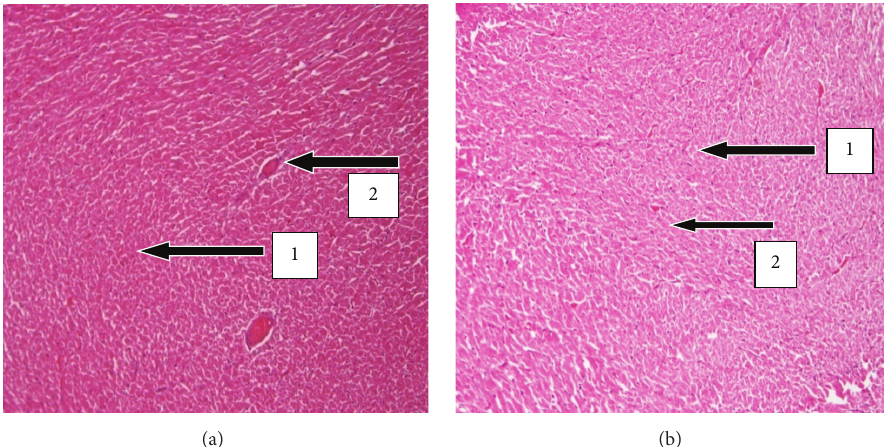
Figure 4: H&E stained sections of hearts at 20x magnification. (a) Heart sections of control SD rats showing normal myocardium. Note the presence of the myocardial fibres with no necrosis (1) and coronary vessels carrying blood normally to the heart (2) . (b) Heart sections of treated animals (2000 mg/kg) showing normal histology and branched myofibrils.